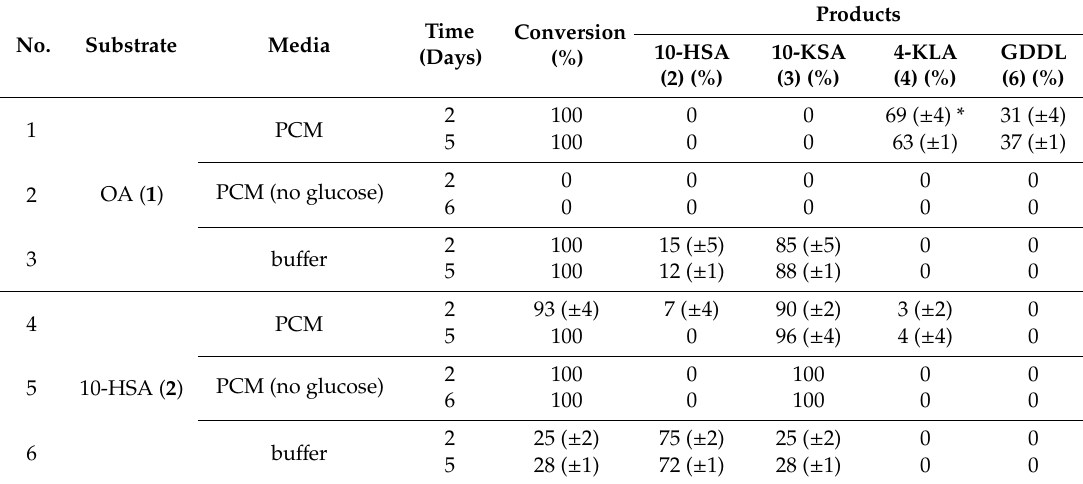
Table 4. Transformation of oleic acid ( 1 ) (0.25%) and 10-hydroxystearic acid ( 2 ) (0.25%) catalyzed